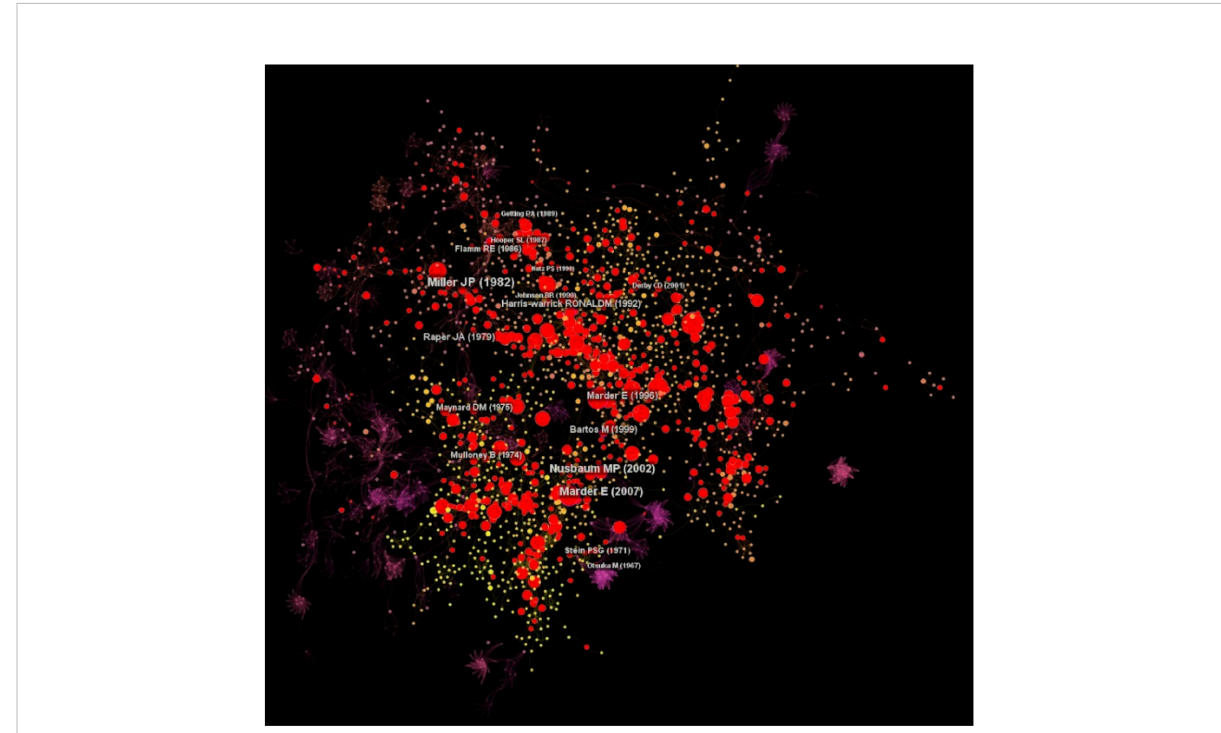
FIGURE 6 Network of document co-citation analysis, where articles with a centrality score greater than 0.1 are shown.